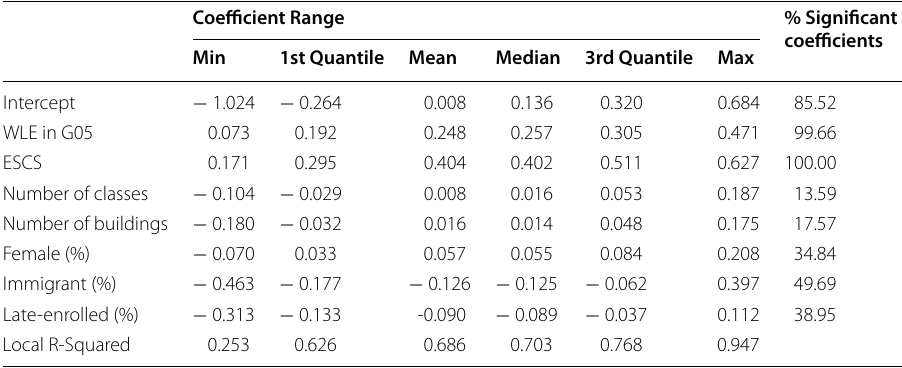
Table 4 Results of the geographically weighted regression (GWR) model Coefficient